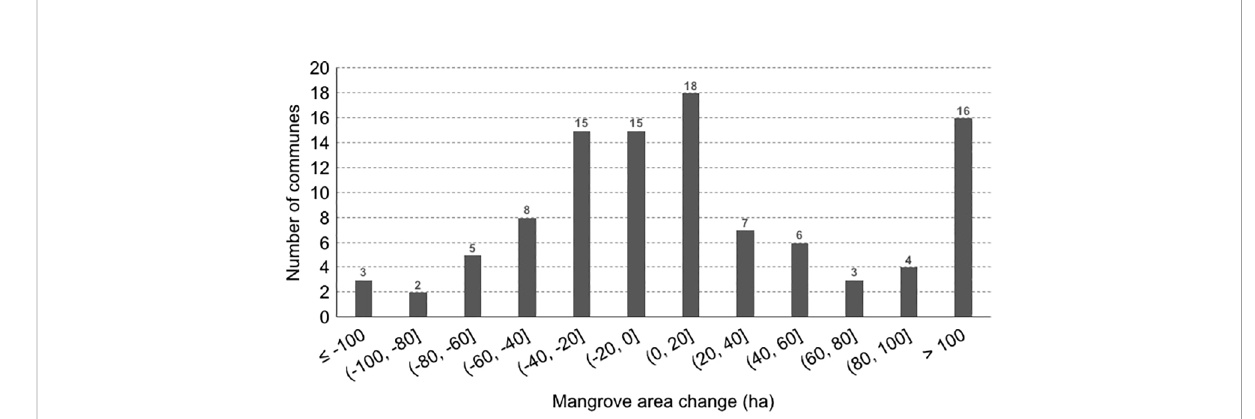
FIGURE 3 Histogram showing the number of communes that lost and gained mangroves during 2015-2020.